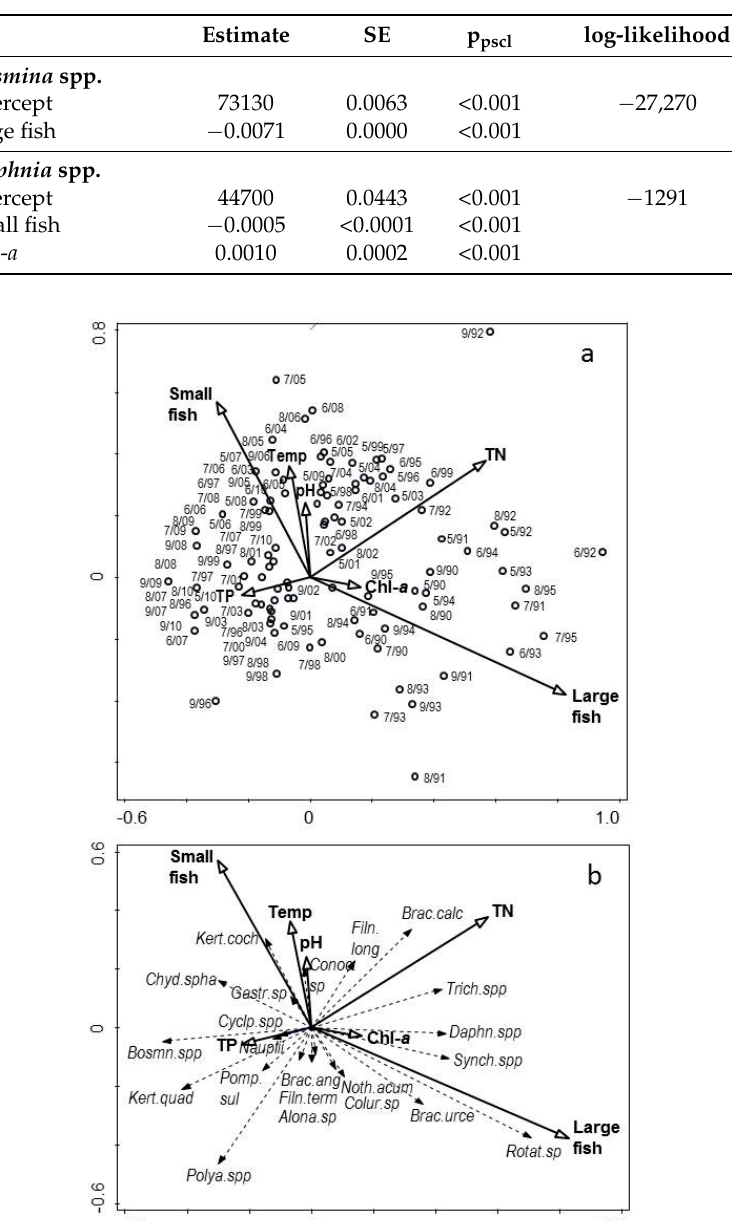
Figure 7. First two axes of the RDA based on zooplankton species density. The ordination of samplings is indicated with open circles ( a ) and references of months and years are given (e.g., 7/05: July 2005). Species scores are indicated with grey arrows, and environmental variables with black arrows ( a , b ). Temp: water temperature; Kert.coch: Keratella cochlearis ; Chyd.spha: Chydorus sphaericus;